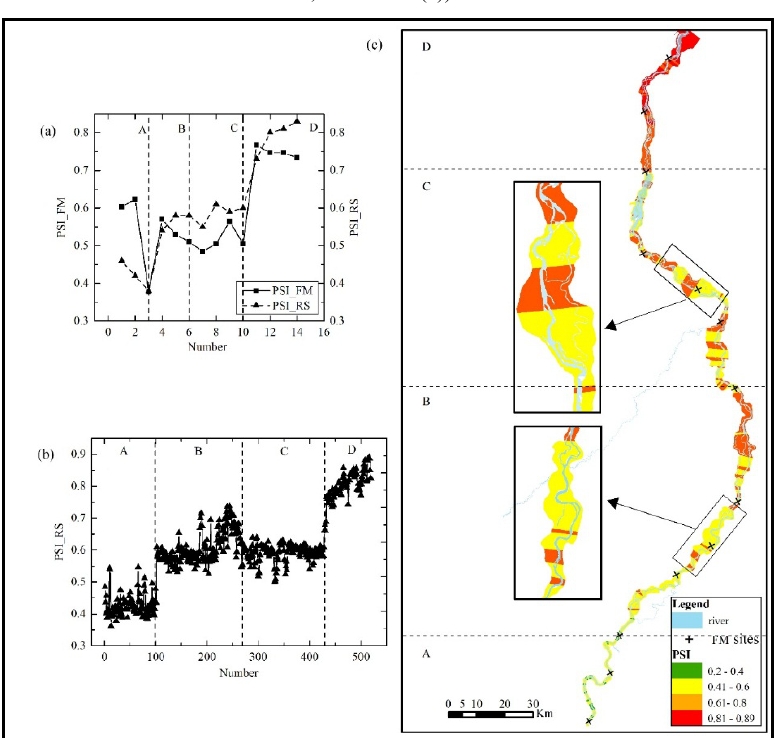
Figure 2. The evaluation result of PSI: (a) was the result of 14 measured sites; (b) and (c) were the result of 520 BEUs; (c) expressed the spatial distribution of result in the form of map. PSI_FM was the evaluating result of PSI calculated by the field measurement, and the PSI_RS was the result calculated based on remote sensing. FM sites was the field measured sites. A, B, C and D were the four measurement sections.